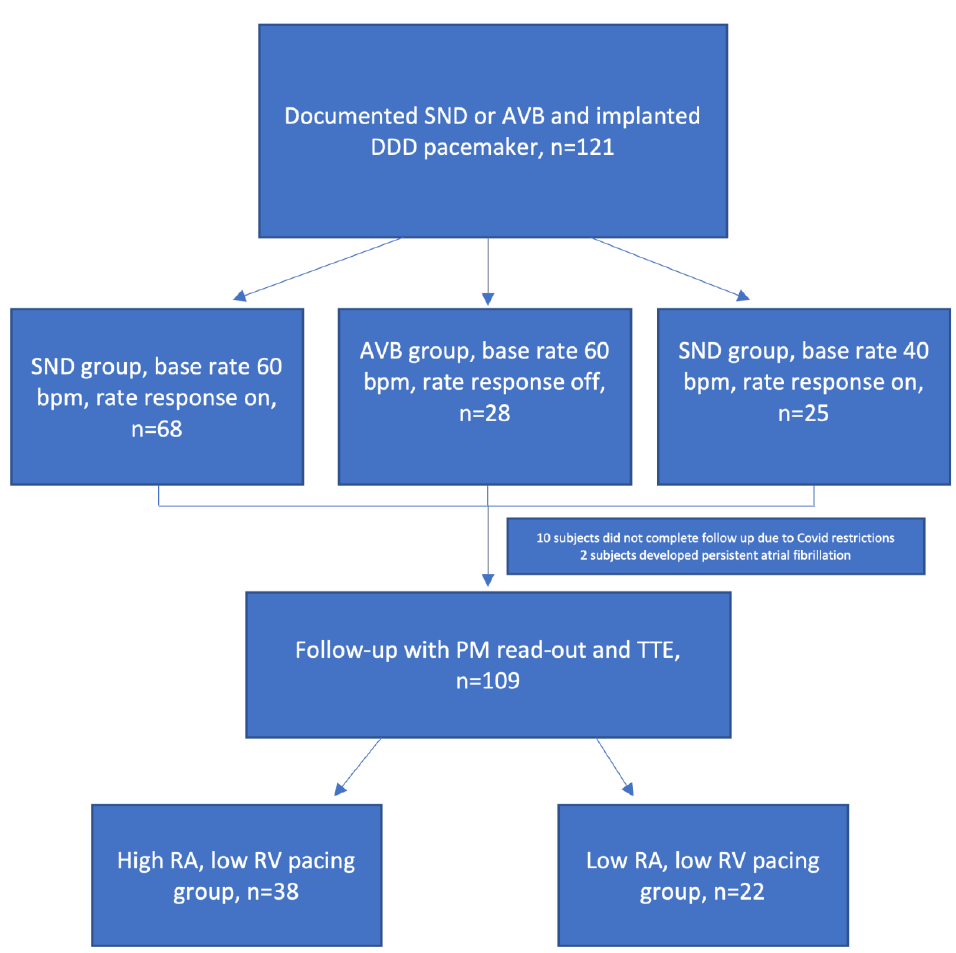
Figure 2. Flowchart of study subjects. AVB — atrioventricular block; bpm — beats per minute; PM-pacemaker; RA — right atrial, RV — right ventricular; SND — sinus node disease; TTE — transthoracic echocardiography. Table 3. Baseline left atrial parameters between high and low right atrial, low right ventricular pacing